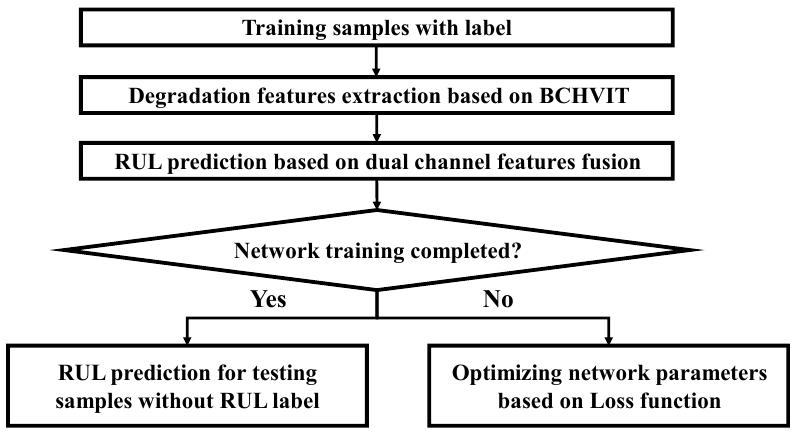
Figure 7. RUL prediction flow chart of this work.